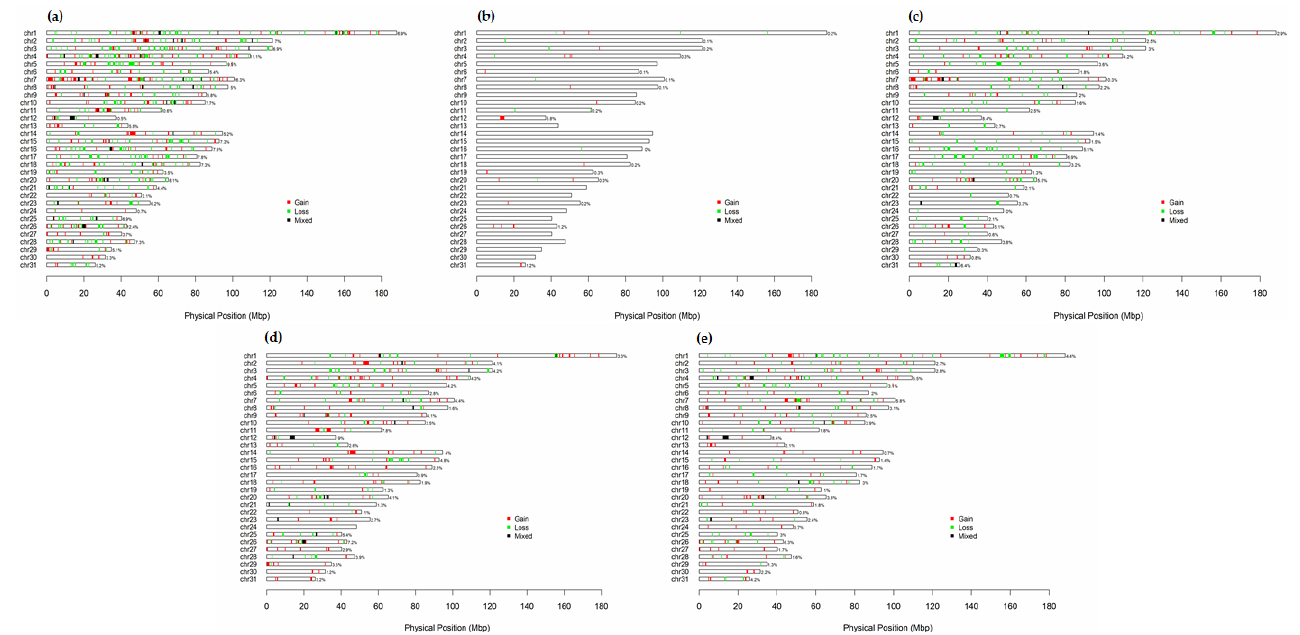
Figure 1. Plot of copy number variation regions (CNVR) on 31 horse ( Equus caballus ) autosomes. ( a ) Total CNVR distribution; ( b ) Jeju horse CNVR distribution; ( c ) Thoroughbred CNVR distribution; ( d ) Jeju riding horse CNVR distribution; ( e ) Hanla horse CNVR distribution. Red, green, and black represent gains, losses, and mixed CNVRs, respectively.